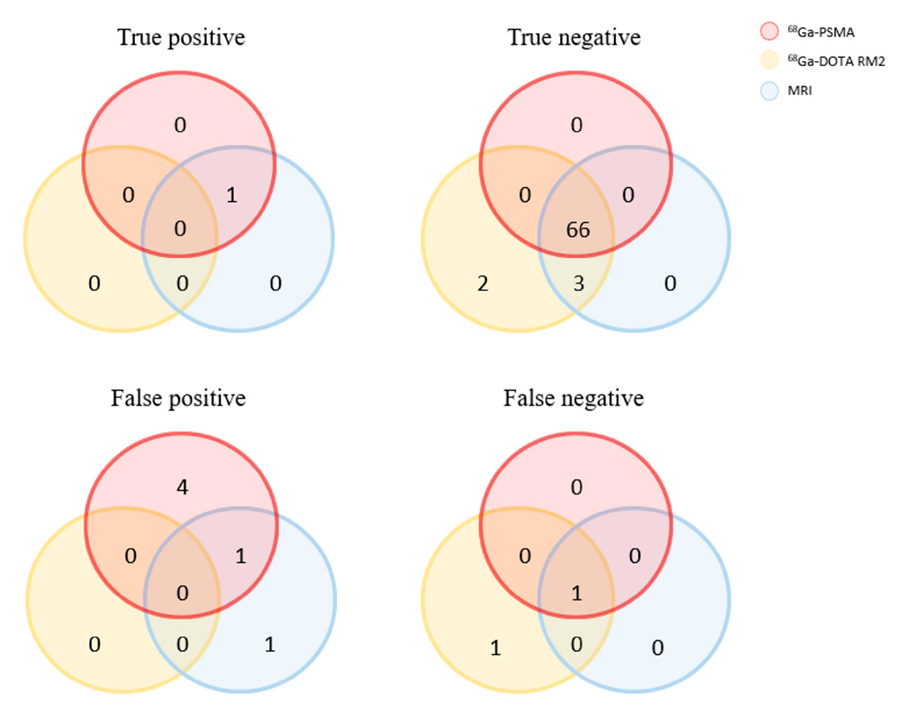
Figure 4. Venn diagram showing the true-positive, false-positive, true-negative and false-negative findings regarding lymph node involvement for all the investigated imaging modalities using histopathological specimens acquired during radical prostatectomy as ground